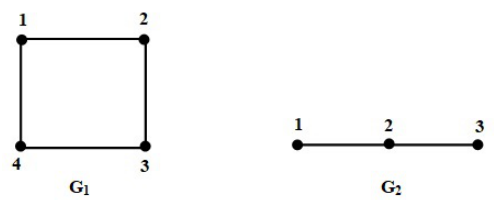
Figure 1. Example for different types of dominating